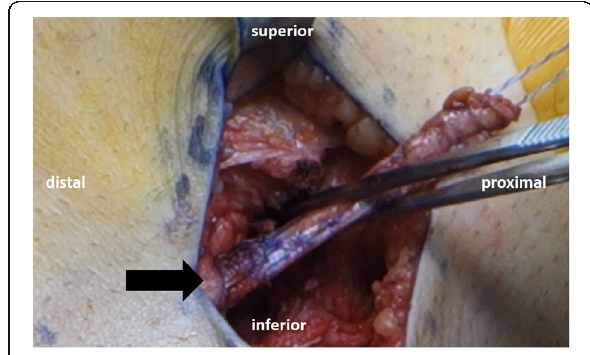
Fig. 6 The modified Lemaire technique on a left knee. A 1cm×8cm strip of iliotibial band is harvested and detached proximally. The graft is passed deep to the LCL (black arrow) and attached superolaterally to the distal femur at Lemaire ’ s point with a staple